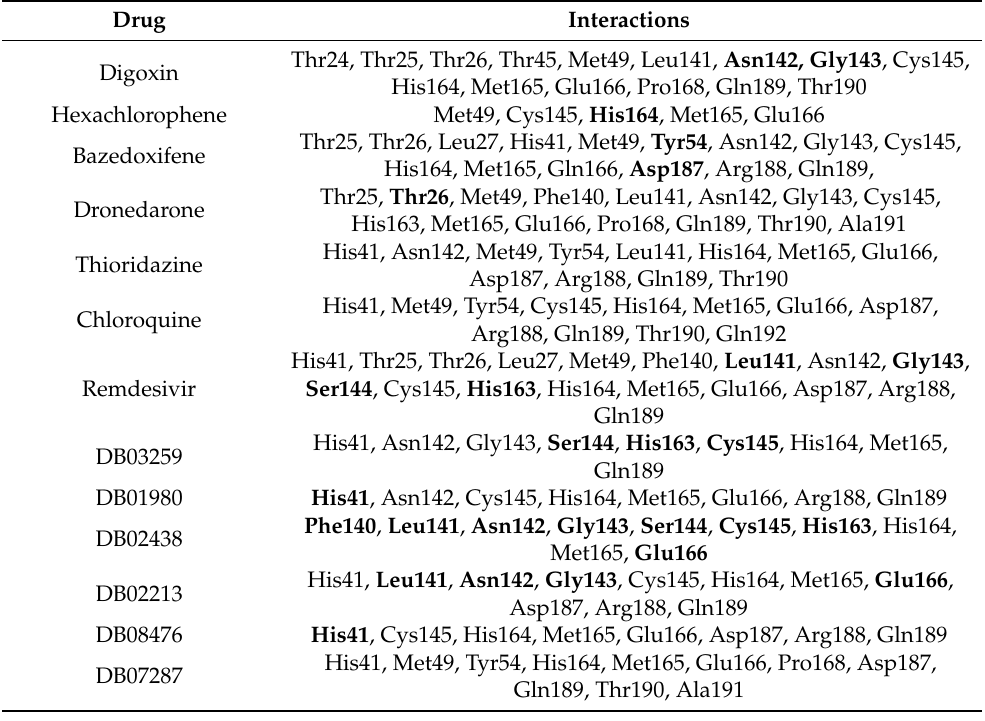
Table 4. Interactions of different drugs with